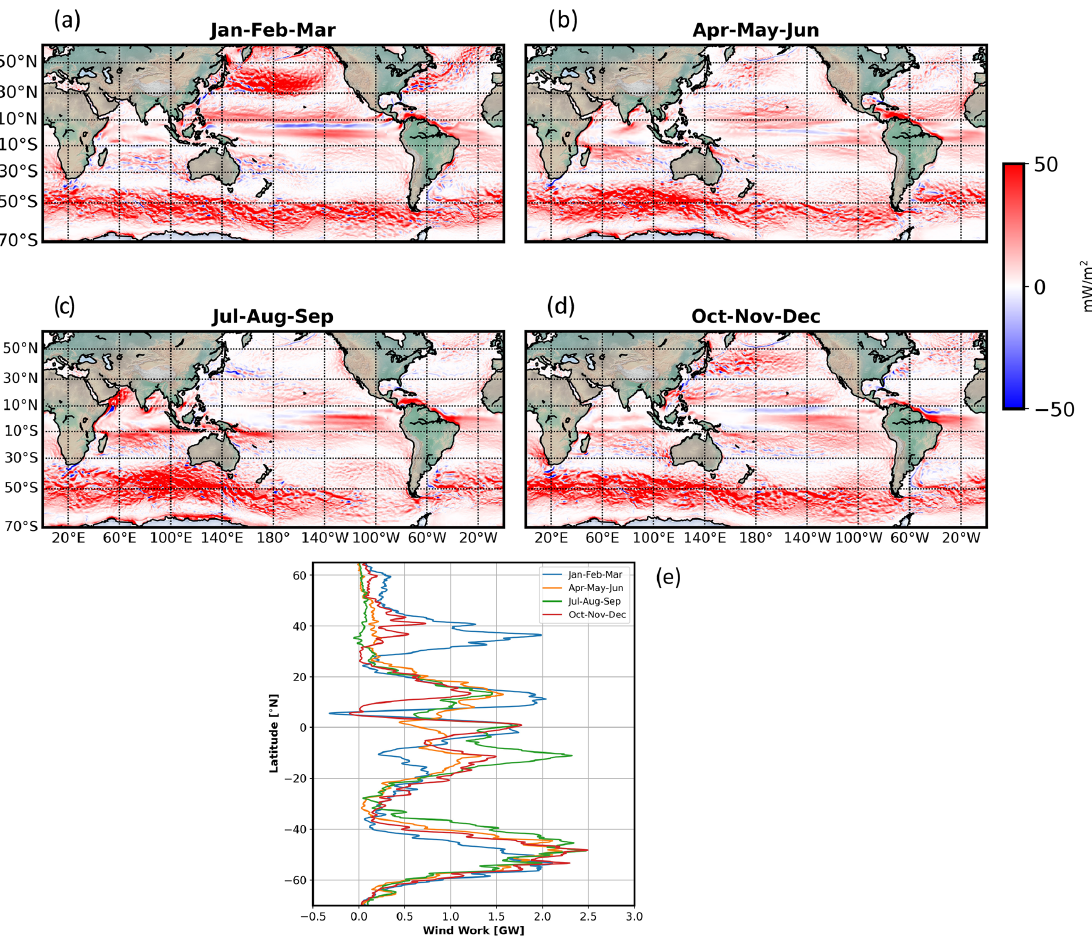
Figure 4. (a–d) Time-mean component of the wind work, τ . u o , in different seasons. (e) Wind work multiplied by the area of the numerical grid cell (m 2 ) and zonally integrated during the four